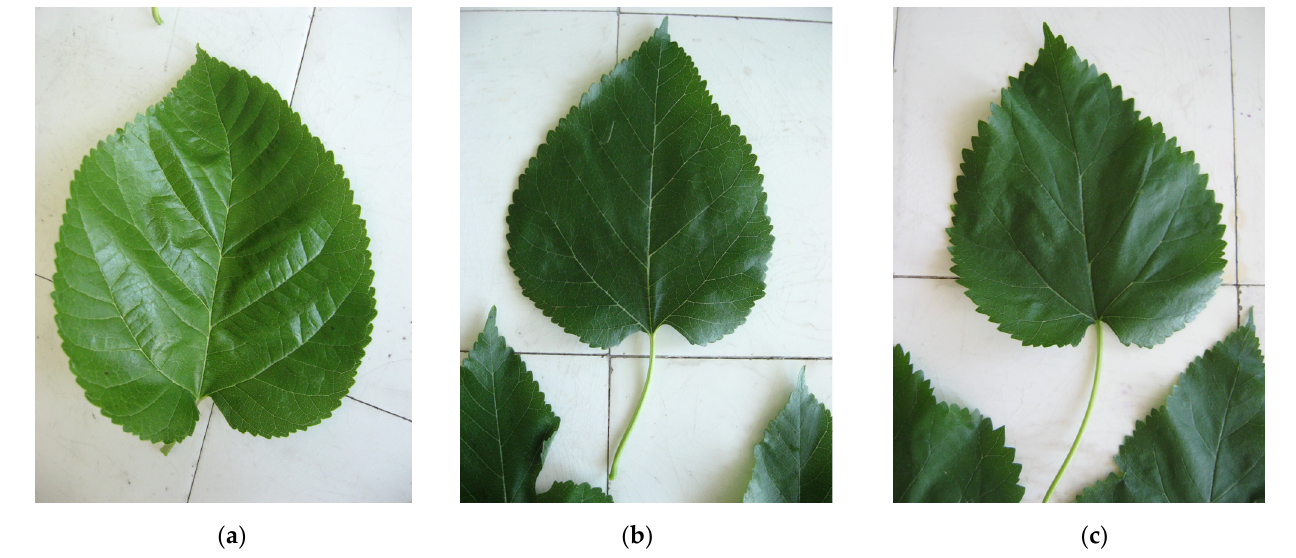
Figure 1. Leaf shape of white mulberry—DJ1 ‘ovate’ ( a ), black mulberry—ZP3 ‘cordate’ ( b ) and red mulberry—MR1 ‘cordate’ ( c ). mulberry—MR1 ‘cordate’ ( c